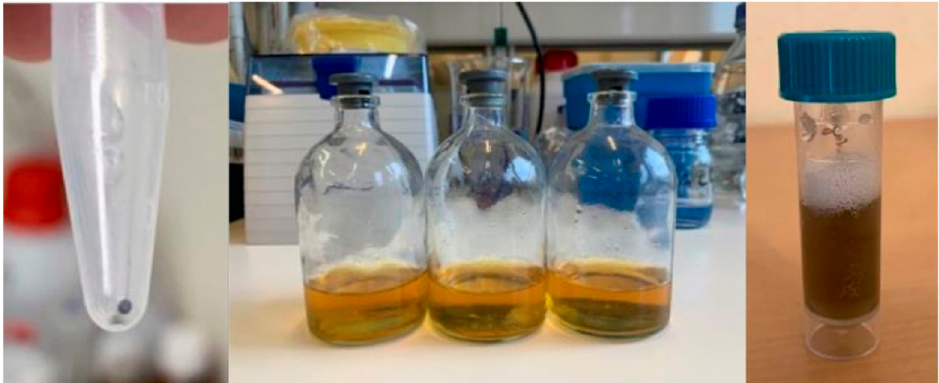
Figure 3. Pellet of the centrifuged sample ( left ), samples prepared for lyophilization (middle) and sample after solvent elimination by evaporation ( right ).